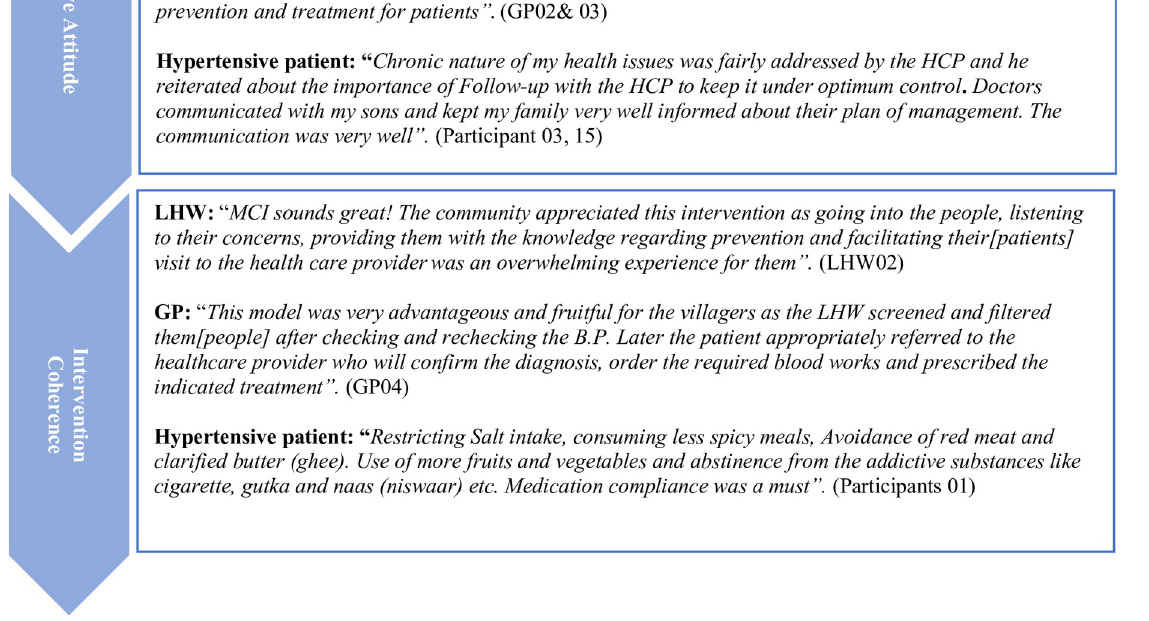
Fig 2. Illustrative quotes from Pakistan